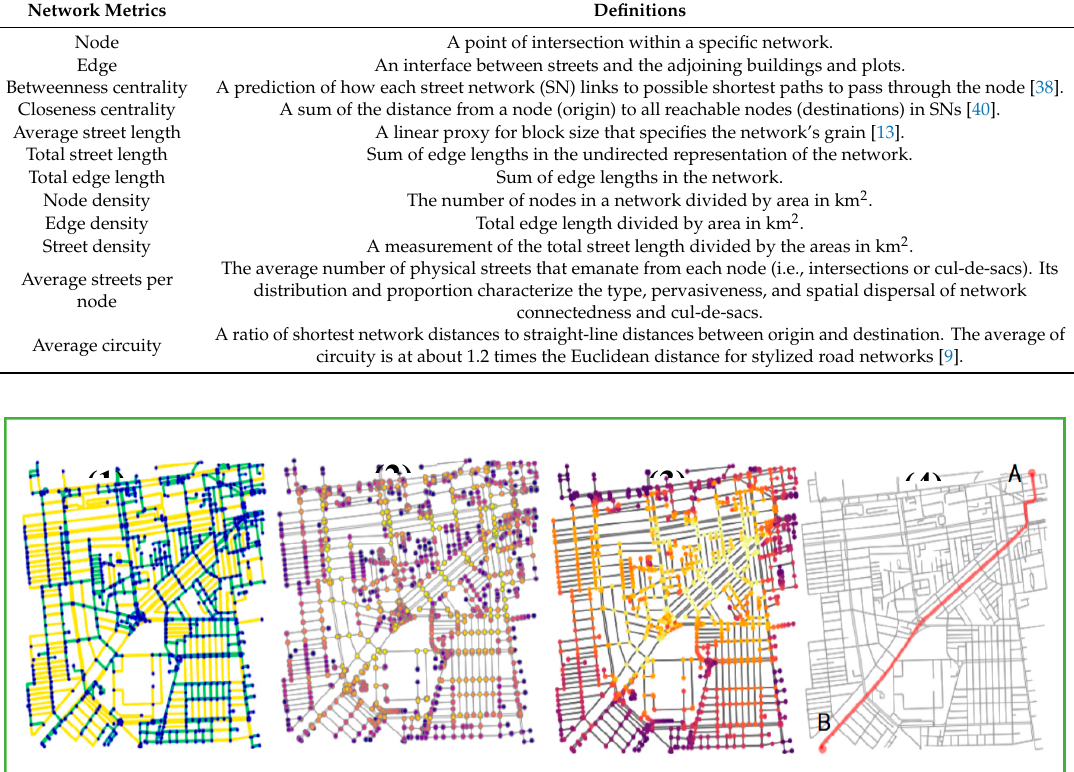
Table 2. Definitions of network metrics.